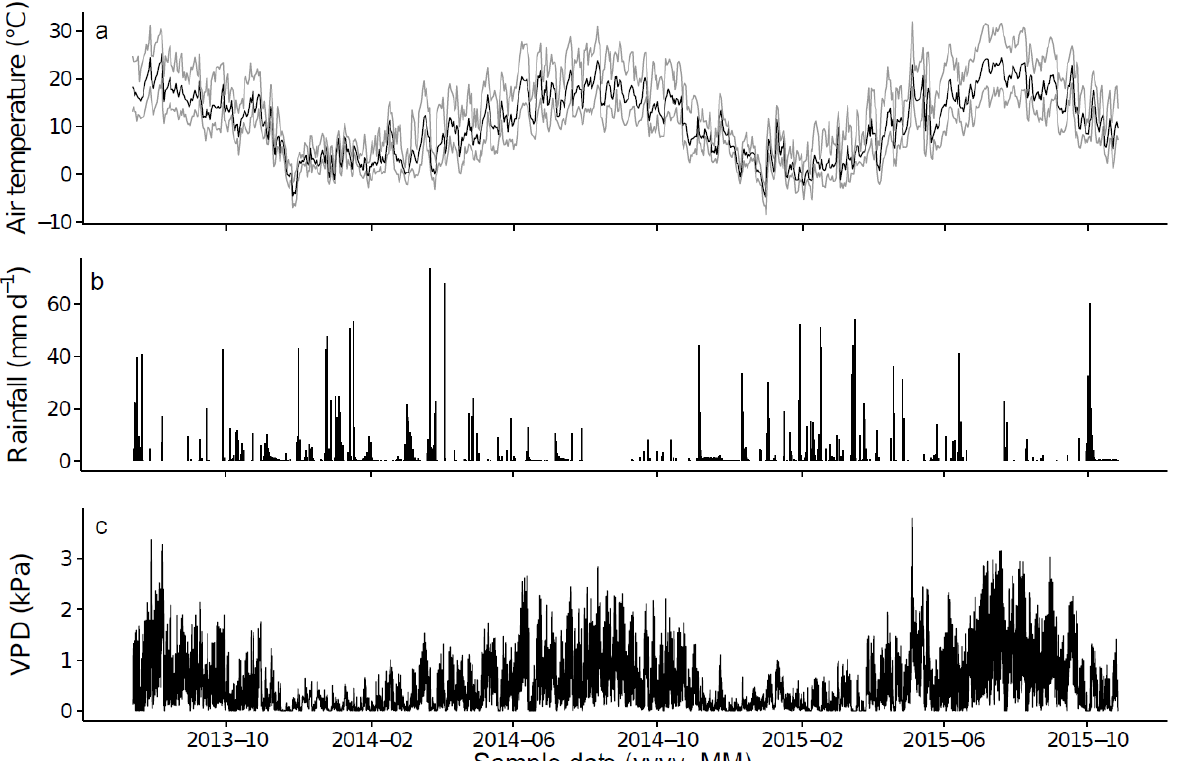
Figure 1. Daily ( a ) mean (black line), minimum and maximum (grey lines) air temperature ( ◦ C), ( b ) total rainfall (mm d − 1 ) and ( c ) continuous VPD (kPa), between 13 July 2013 and 26 October 2015. The dashed vertical line represents the date of the prescribed burning.